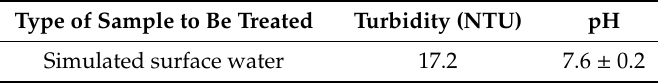
Table 2. Initial sample properties (simulated surface